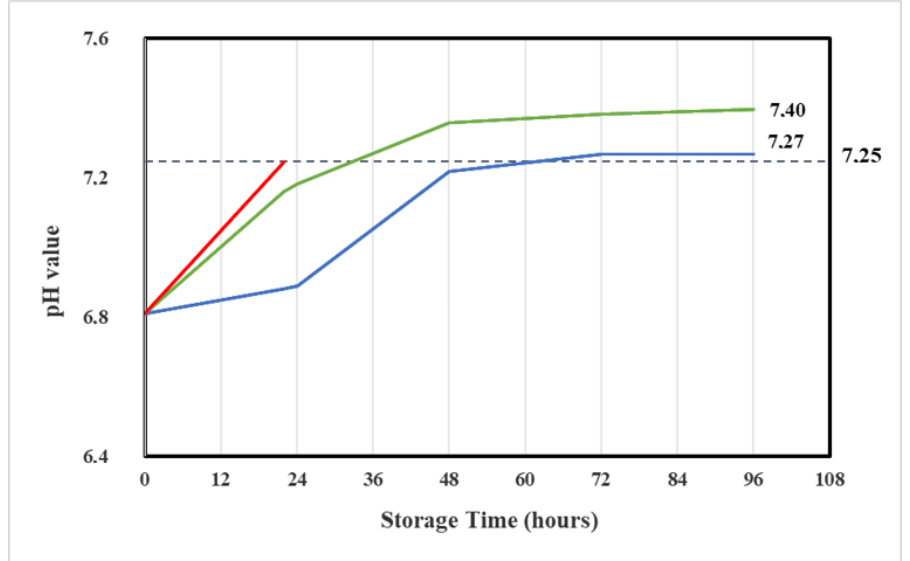
Figure 8. Trend of the mean pH of Vidaza ® (25 mg/mL) stored in the original container over 22 h (red line), in a polypropylene syringe (green line), and in a polypropylene syringe placed between two refrigerant gel packs (blue line) over 96 h. The dotted line represents the mean pH in the original container at 22 h.